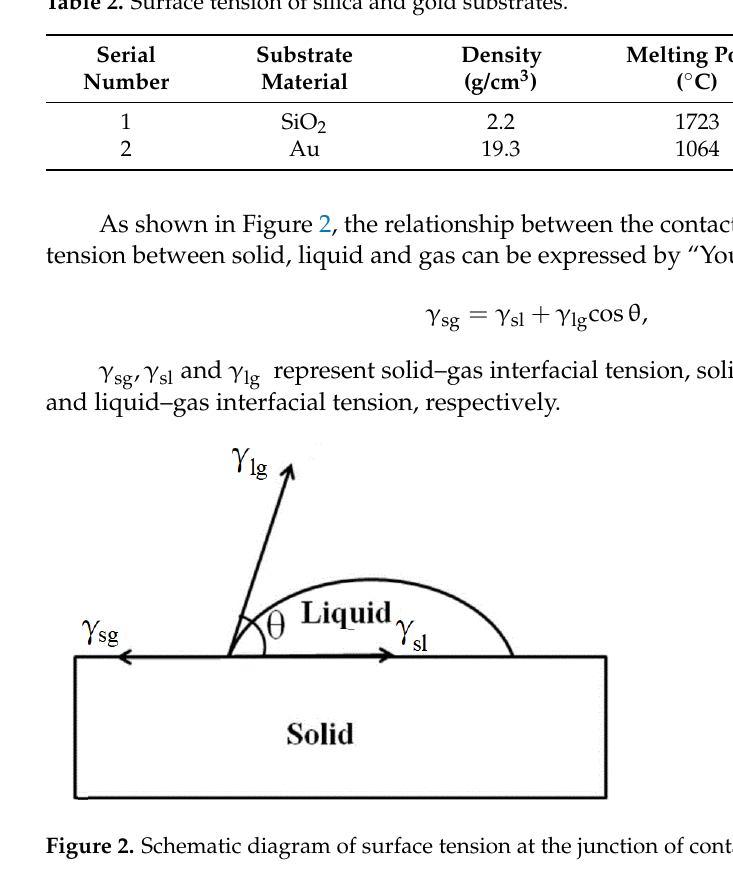
Table 2. Surface tension of silica and gold substrates.